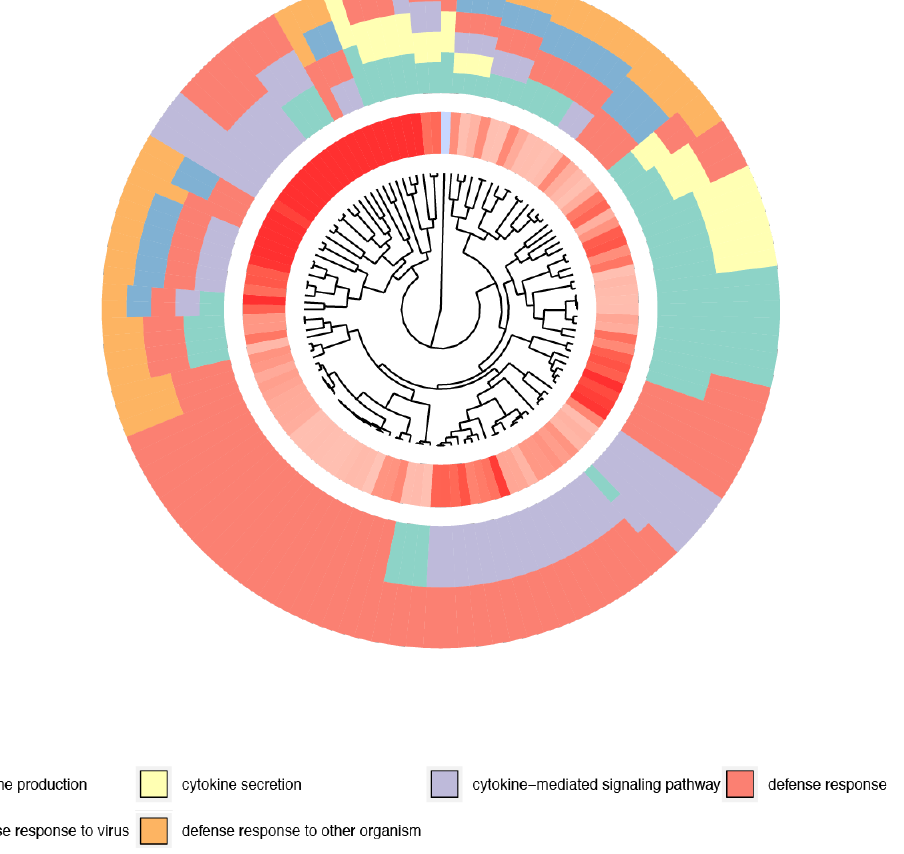
Figure 3. Dendrogram of the differentially expressed genes involved in “defense response to other organism”, “defense response”, “defense response to virus”, “cytokine secretion”, “cytokine production” and “cytokine-mediated signaling pathway” GO BP terms. The DEGs were clustered based on their logFC values.